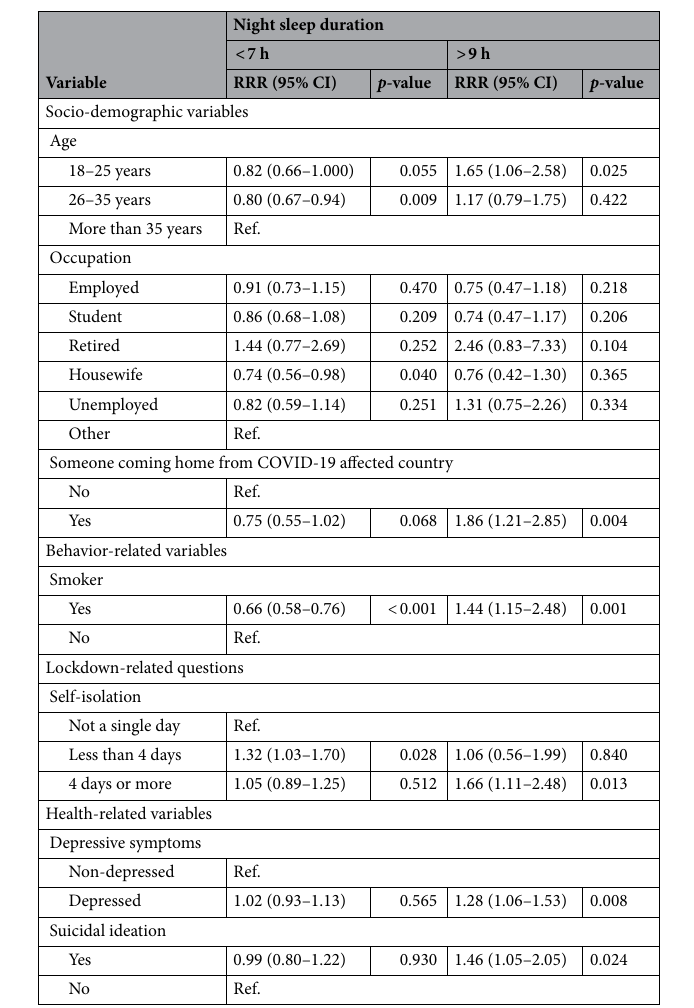
Table 6. Multinomial logistic regression between study variables and night sleep duration. RRR. relative risk ratio; CI, confidence interval; Recommended sleep duration (7–9 h) considered as base